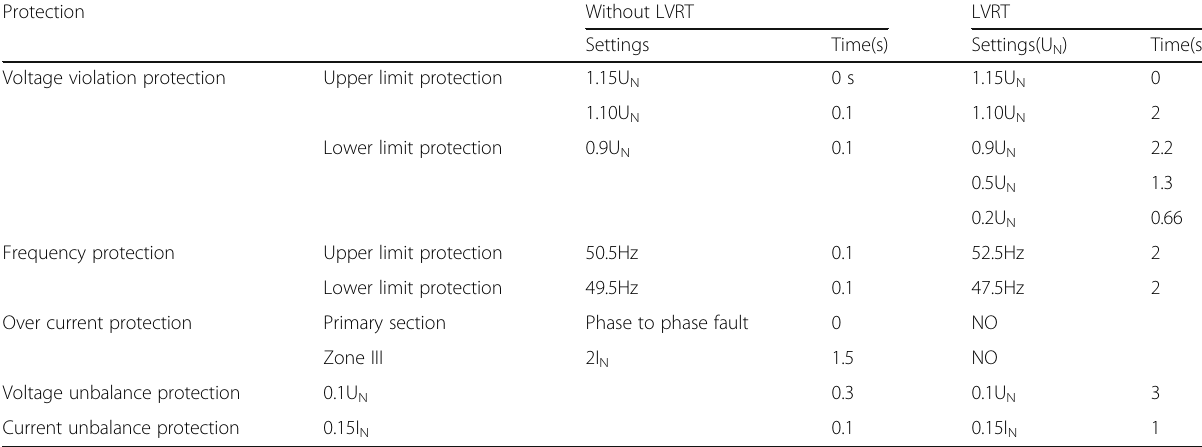
Table 1 Comparison between the conventional protection and improved protection Protection